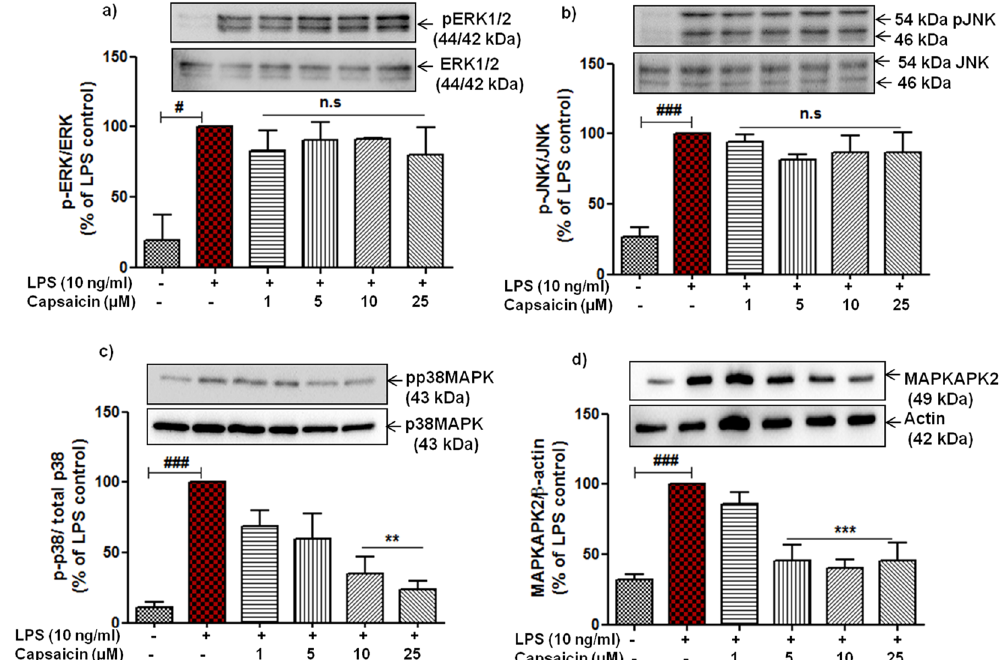
Figure 7. Effects of capsaicin (cap) on the activation of ERK 1/2, JNK, p38 and MK2. Cells were pre-treated with cap (1–25 µ M) for 30 min followed by stimulation with or without LPS (10 ng/ml) for 30 min. Whole cell lysates were subjected to western blots analyses. After the successful transfer of protein, membranes were blocked and eventually cropped horizontally between 60 kda and 35 kda (depending on the size of protein) to get all the target proteins. Representative blots (upper panel) and densitometry analyses (lower panel) are shown ( a ) ERK1/2, ( b ) JNK, ( c ) p38 MAPK, and ( d ) MAPKAPK2 or MK2. Representative original blots are included in Supplementary Fig. S10. Statistical analyses were carried out by using one way ANOVA with post hoc student Newman-Keuls test (multiple comparisons). Results are expressed as means ± SE of 3–4 independent experiments. # p < 0.05; ### p < 0.001 compared with control cells. ** p < 0.01, *** p < 0.01 compared with LPS (10 ng/ml) activated